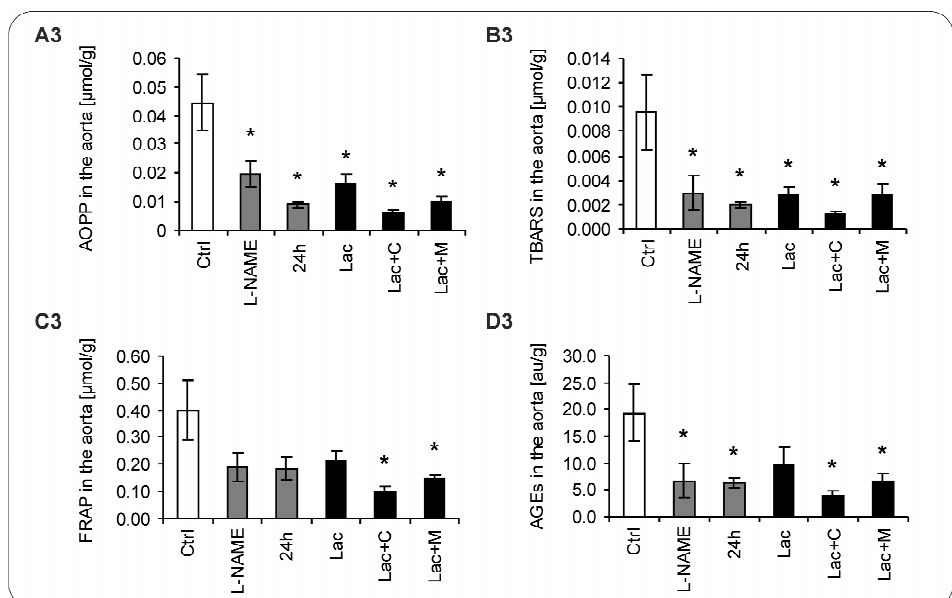
Figure 5. The parameters of oxidative status in plasma ( A1 – D1 ), left ventricle (LV) ( A2 – D2 ) and aorta ( A3 – D3 ) in the control group (Ctrl), L-NAME (L-NAME)-, continuous 24 h/day light (24 h)-, lactacystin (Lac)-induced hypertension and in lactacystin-hypertension influenced by captopril (Lac+C) or melatonin (Lac+M). * p < 0.05 vs. Ctrl.